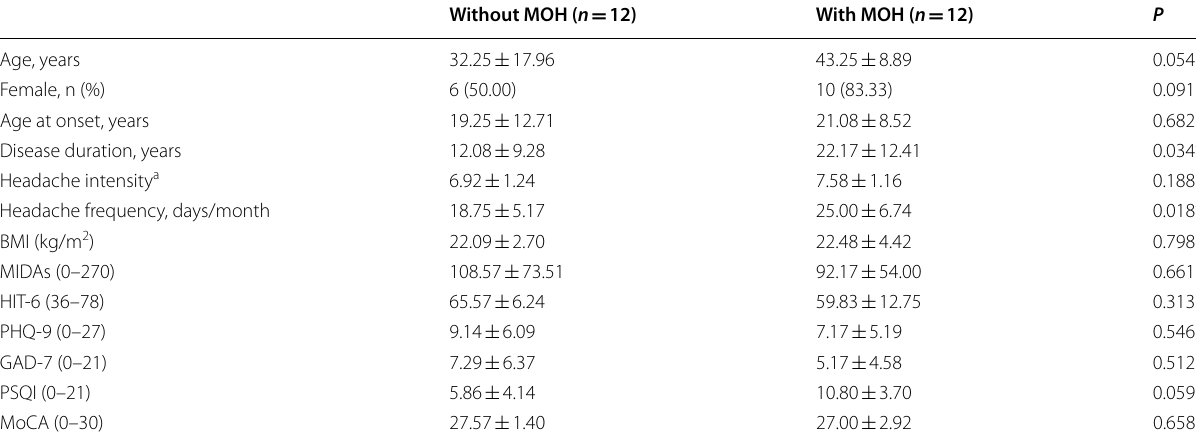
Table 2 Comparisons of demographics and clinical characteristics between CM with and without MOH